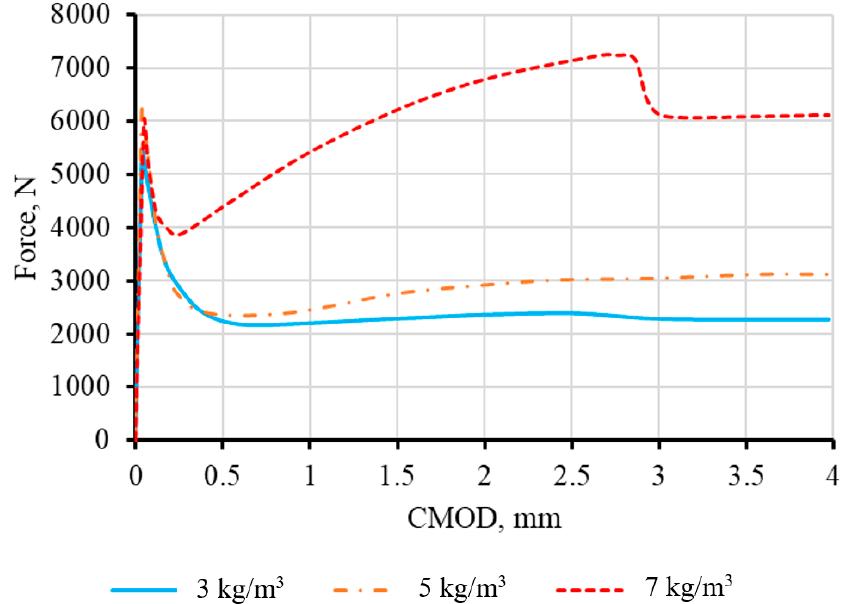
Figure 3. Force versus CMOD from the bending test conducted on the specimen in a form of a beam reinforced by different macrofiber mass amount.